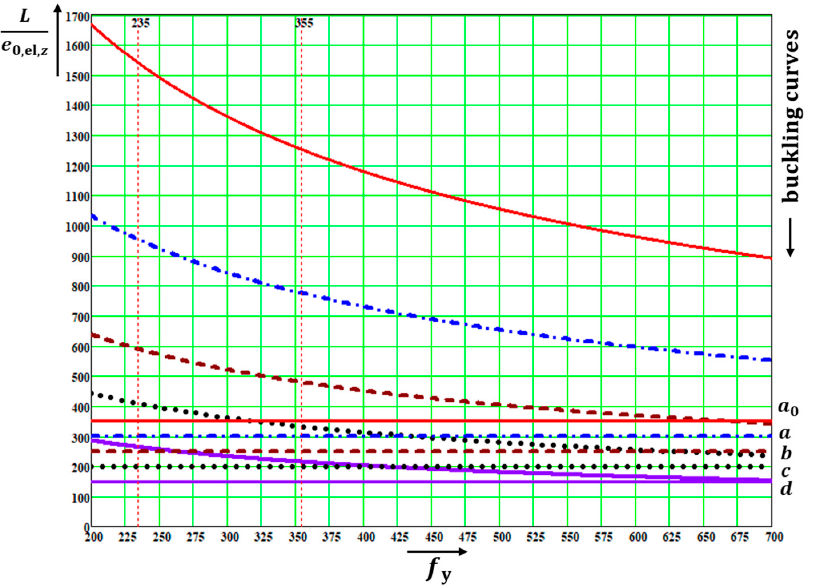
Figure 20. Comparison of horizontal lines [7] to the curves [18] defining bow imperfection 𝑒 (cid:2868),(cid:2915)(cid:2922),(cid:2936) . It is evident in the UGLI imperfection method that safety factor 𝛾 (cid:2897)(cid:2869) cannot be re- moved from 𝑒 (cid:2868),(cid:2914), and value 𝑒 (cid:2868),(cid:2921) cannot be used in this method. See comparisons in Ta- bles 8 and 9.